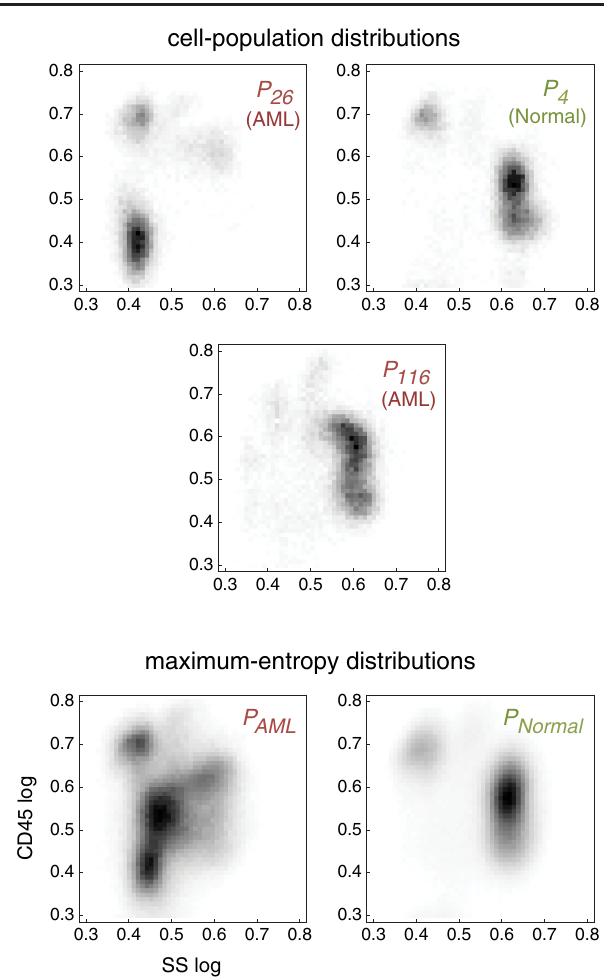
SS log FIG. 1. Molecular and morphological landscapes of leukemia. The two-dimensional distribution of cells with given values of the logarithms of the side scatter (SS log) and the marker CD45 (CD45 log) intensities are shown for representative cell popula- tions, with black and white representing high and zero densities, respectively. The distributions for AML patient no. 26 ( P ) and 26 normal individual no. 4 ( P 4 ) are indicative of distributions that closely resemble the maximum-entropy distribution of their state, either AML ( P ) or normal ( P ) states. The distribution AML normal for AML patient no. 116 ( P 116 ), in contrast, does not show a clear discriminative feature of the presence of AML in the SS-CD45